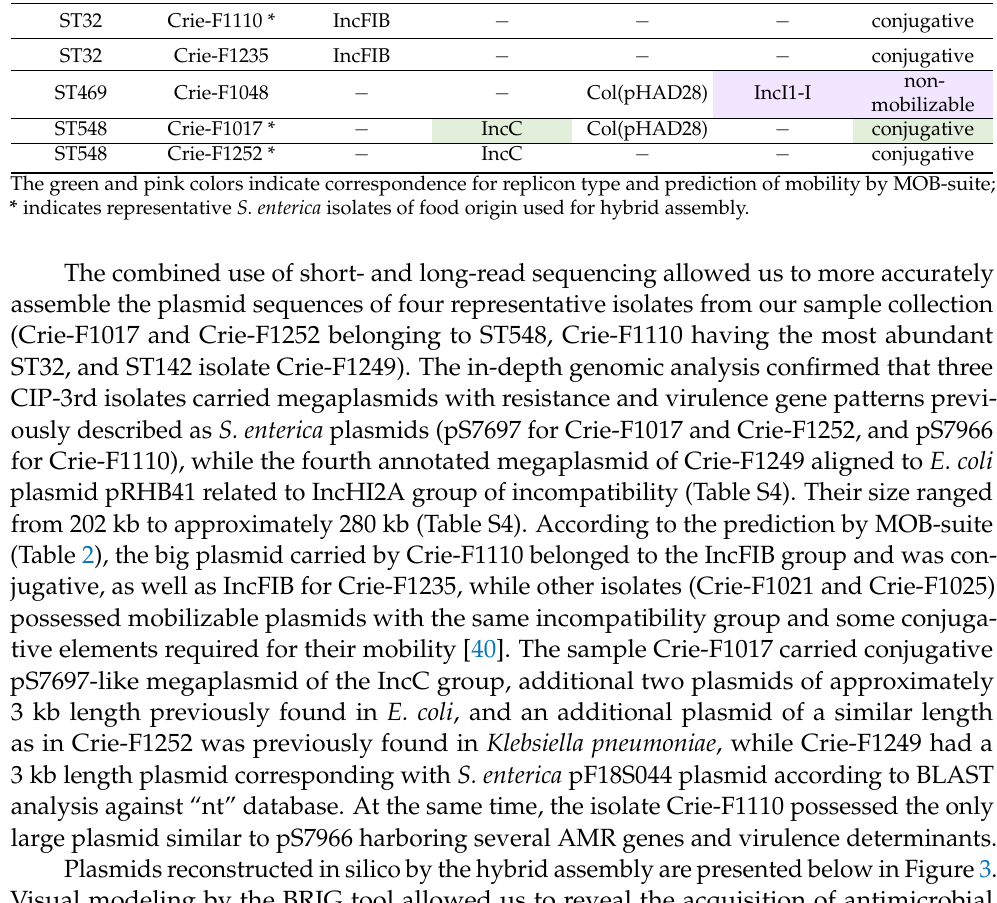
Table 2. Plasmid replicon sequences found in the isolates. Plasmid Replicons Predicted MLST Isolates MobilityIncF IncC Col Others IncFIB, − − IncI1-I ST11 Crie-F1247 IncFII IncHI2, ST142 Crie-F1249 * − − Col(pHAD28) conjugative IncHI2A ST32 Crie-F1021 IncFIB − − − mobilizable ST32 Crie-F1025 IncFIB − − − mobilizable non- ST32 Crie-F1089 IncFIB − − − mobilizable ST32 Crie-F1104 IncFIB − − − ST32 Crie-F1110 * IncFIB − − − conjugative ST32 Crie-F1235 IncFIB − − − conjugative non- ST469 Crie-F1048 − Col(pHAD28) IncI1-I mobilizable ST548 Crie-F1017 * − IncC Col(pHAD28) conjugative ST548 Crie-F1252 * −